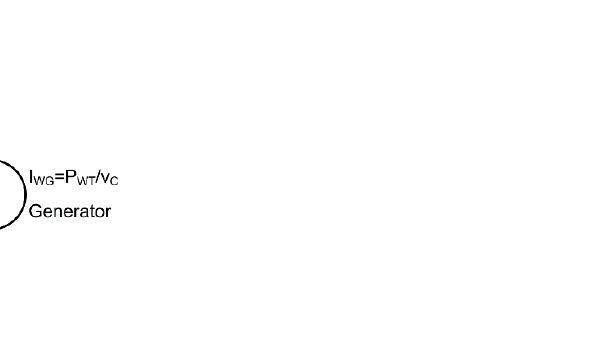
Figure 6. PM simulation model, where the wind generator has been replaced by a current source.